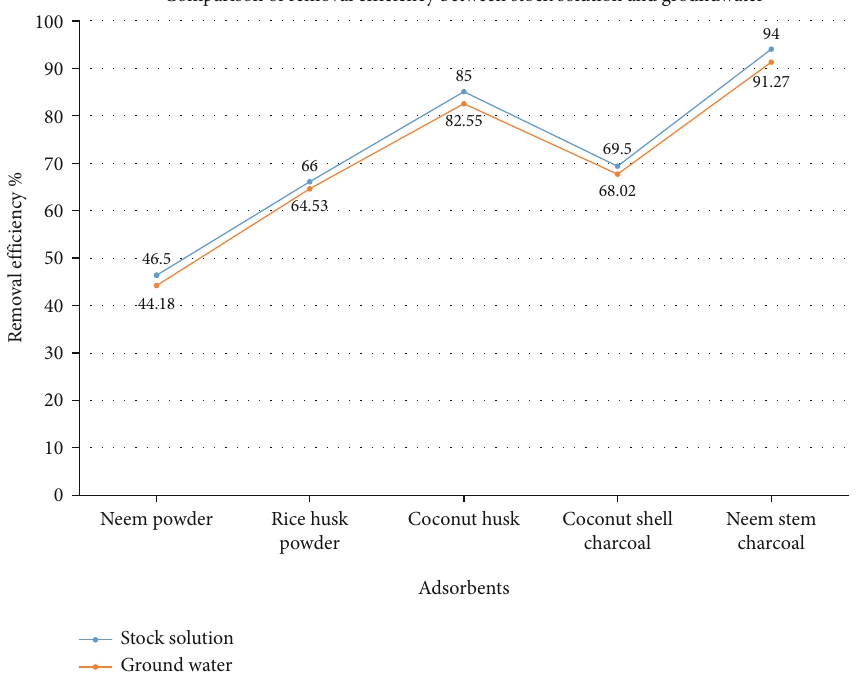
Figure 9: Comparison graph of removal e ffi ciency between stock solution and Table 3: Adsorbent concentration and contact time for treating groundwater.